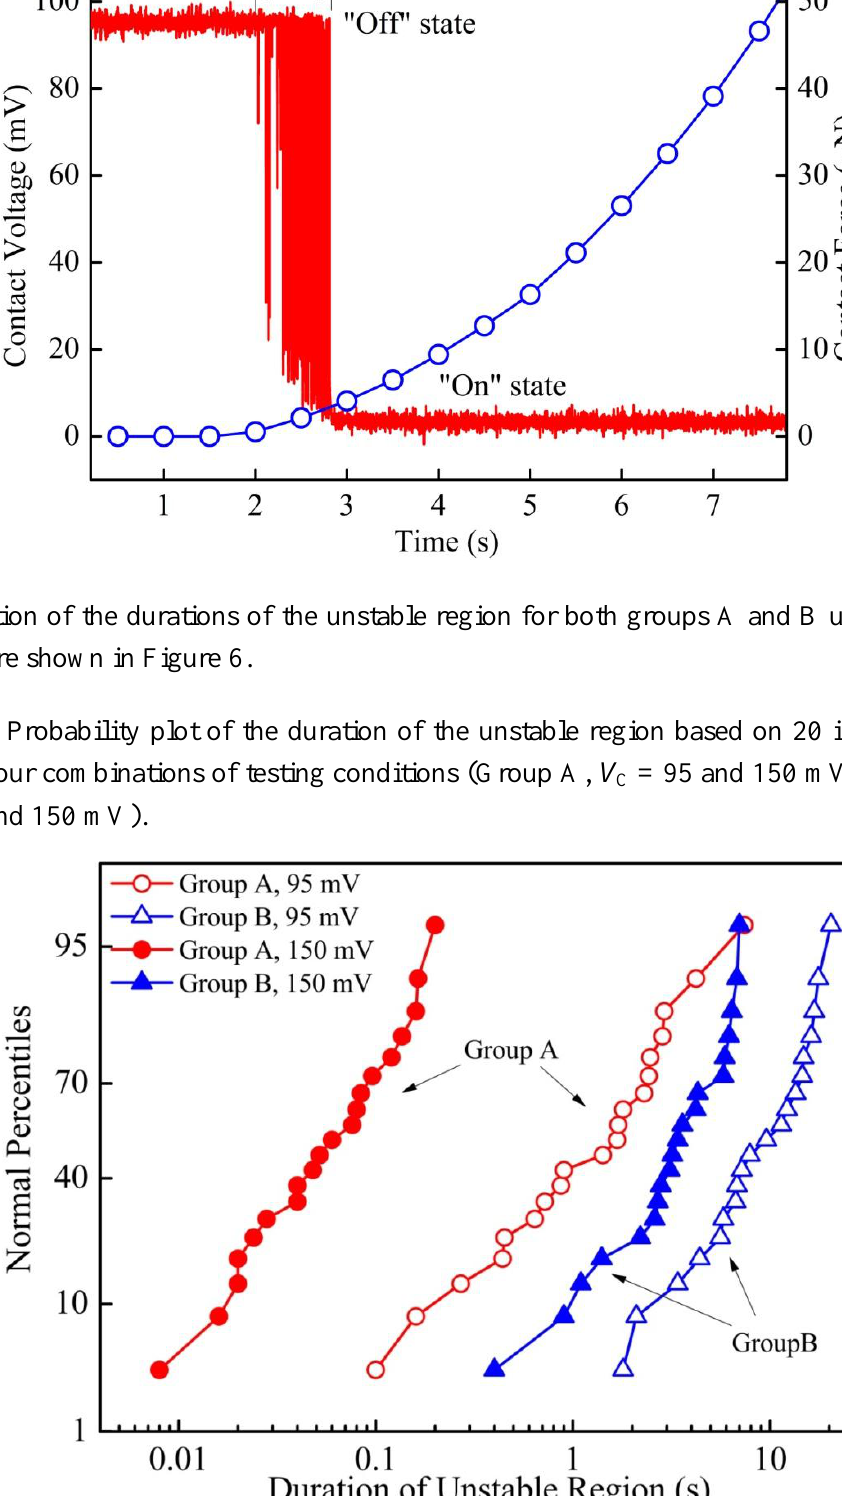
Figure 5. Contact voltage and contact force as functions of time for a typical Au-Au contact in Group A.